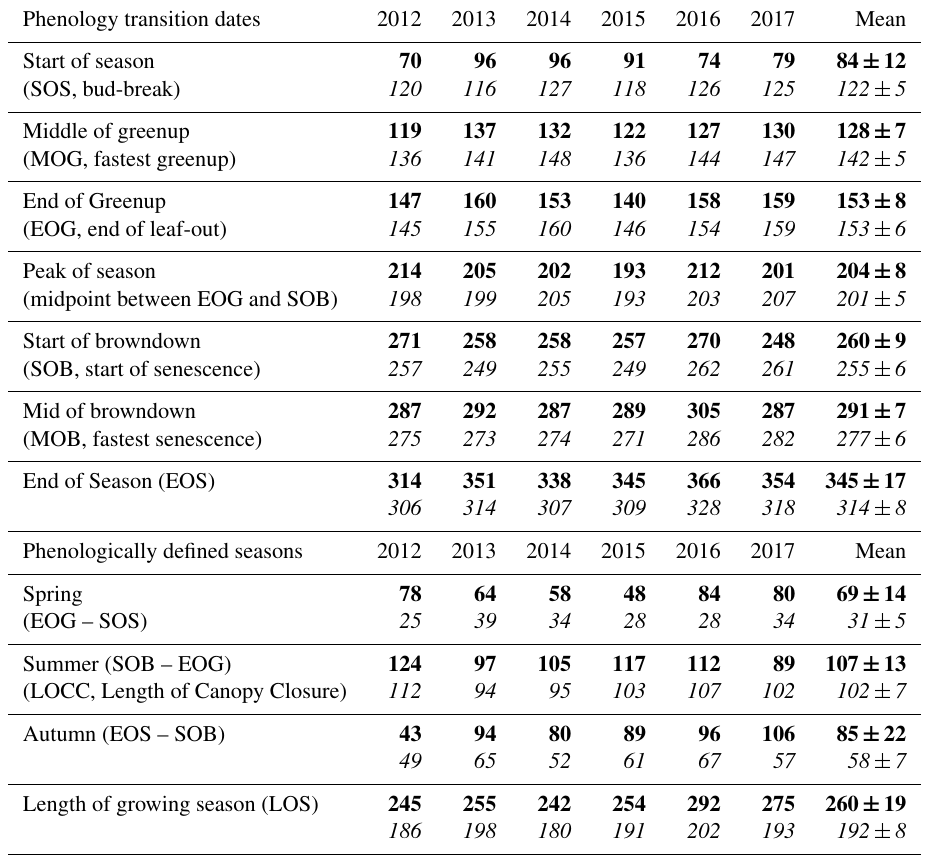
Table 2. The top section of the table contains the annual calculated phenological dates (reported as day of year) for both the conifer (TP39, bold) and deciduous (TPD, italicized) forests from the year 2012 to the year 2017. Phenological dates were calculated following Gonsamo et al. (2013) from eddy-covariance-measured GEP max data. The 6-year mean values and standard deviations are included in the final column. The resulting phenological periods (seasons) and their duration in days are also shown, in the lower section of the